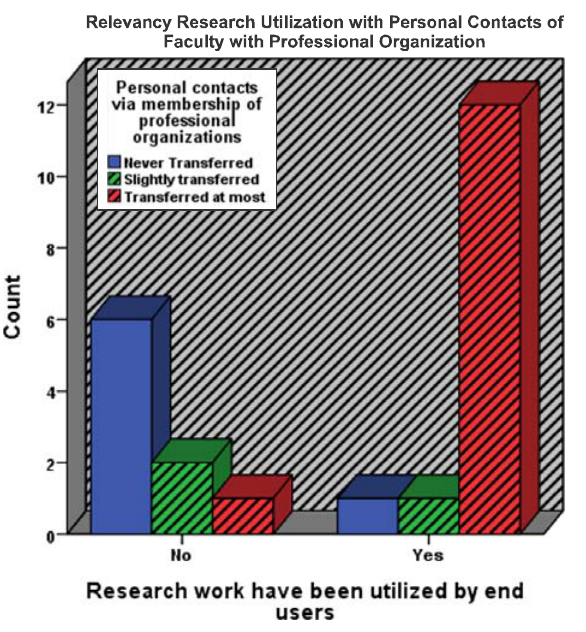
FIG. 5. ROLE OF CONTACTS VIA ALUMNI ORGANIZATIONS TOWARDS UTILIZATION OF KNOWLEDGE CAPITAL